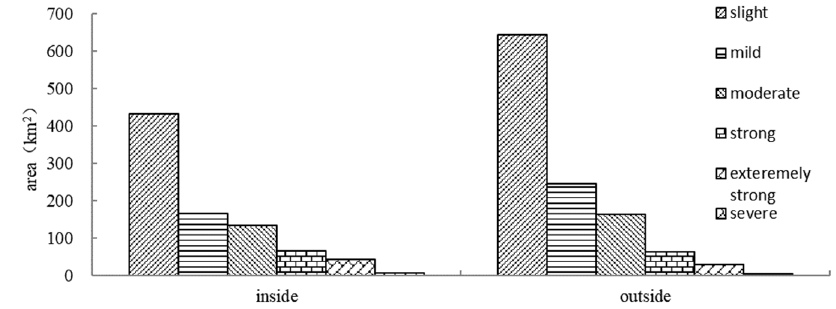
Table 7. Modulus of soil erosion in different years inside and outside the environmental greening project in the South and North Mountains of Lanzhou City (unit: t/(km 2